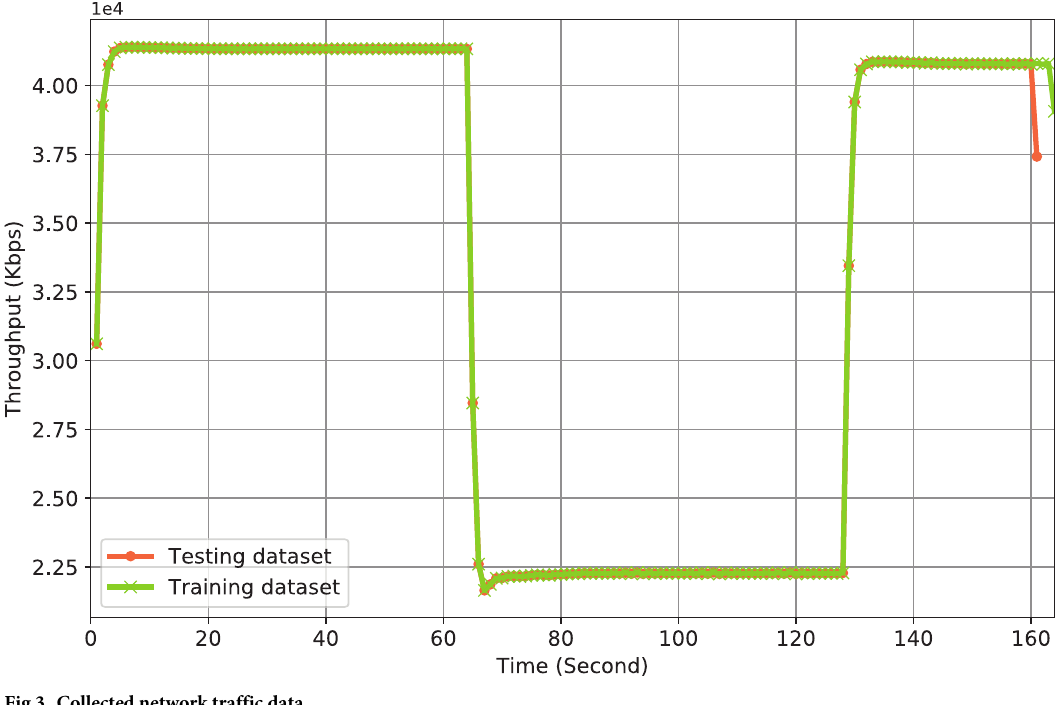
Fig 3. Collected network traffic